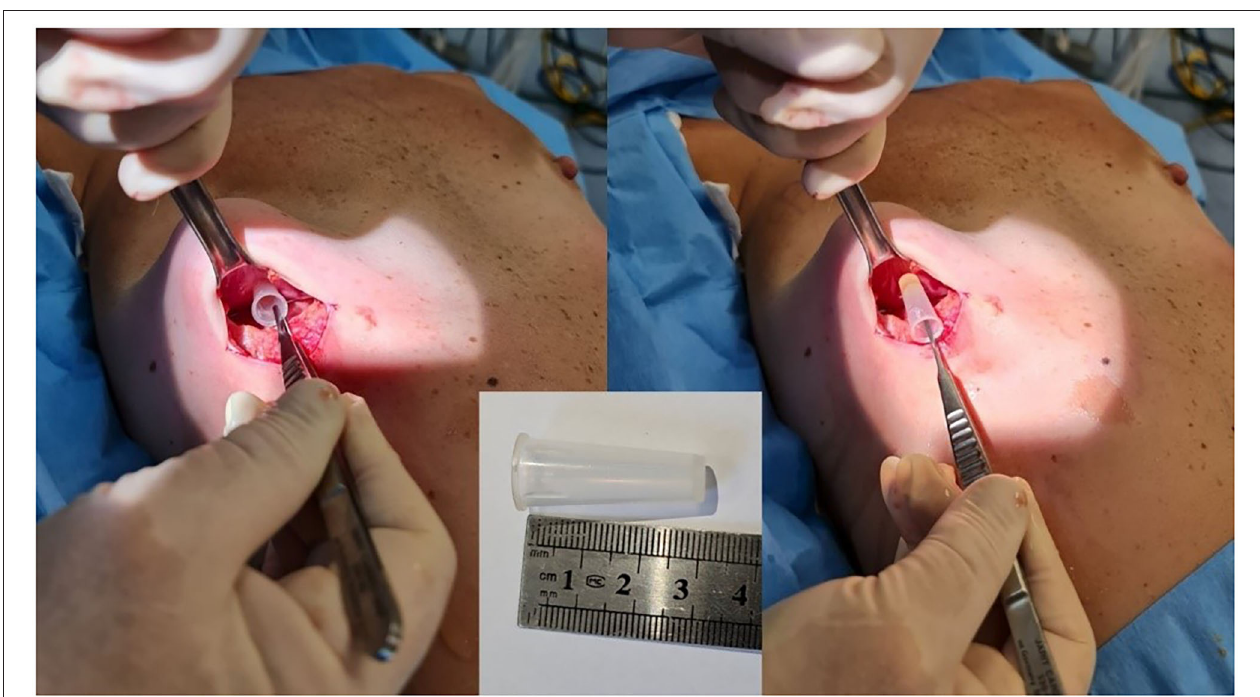
FIGURE 4 | Intra-operative picture. Extraction of a foreign object from the right breast